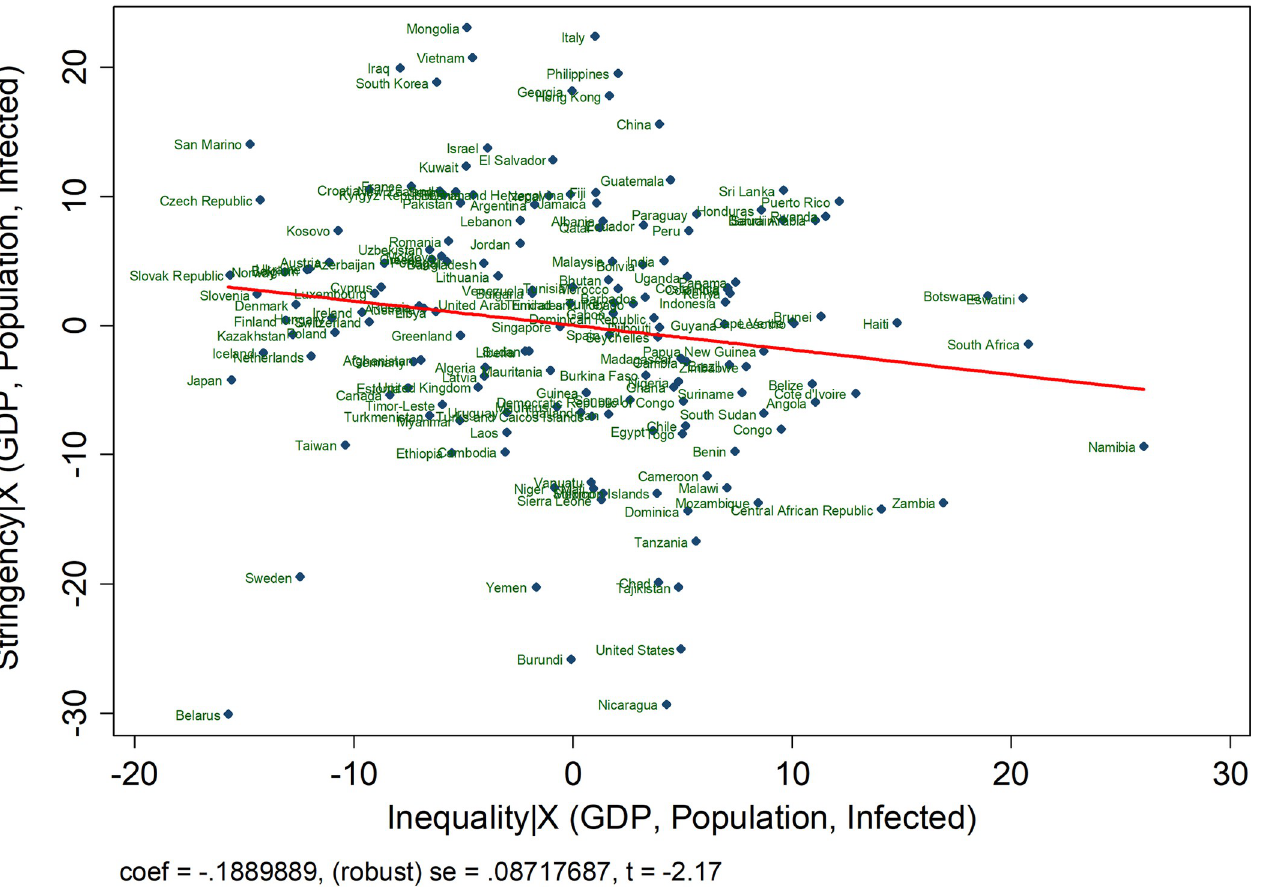
Fig 1. Adjusted relationship between inequality and policy stringency from February 1, 2020 to April 14, 2020. This figure plots the relationship between stringency of country-level COVID-19 policies and inequality, controlling for countries’ population, GDP per capita, and exposure to the disease. Stringency is measured by the Oxford Covid Government Response tracker program, ranking countries’ daily policy on a standardized scale ranging between 0 (not stringent at all) to 100 (highly stringent). We limit the range to the period between February 1st, 2020 after the disease had already been discovered outside of China, but before April 14th, 2020, the day before our survey data was initiated. The index is comprised of seven indicators of lockdown, such as school closures and restrictions in movement, which are consistent with our survey questions below. We measure inequality using the SWIID database (Solt, 2019).